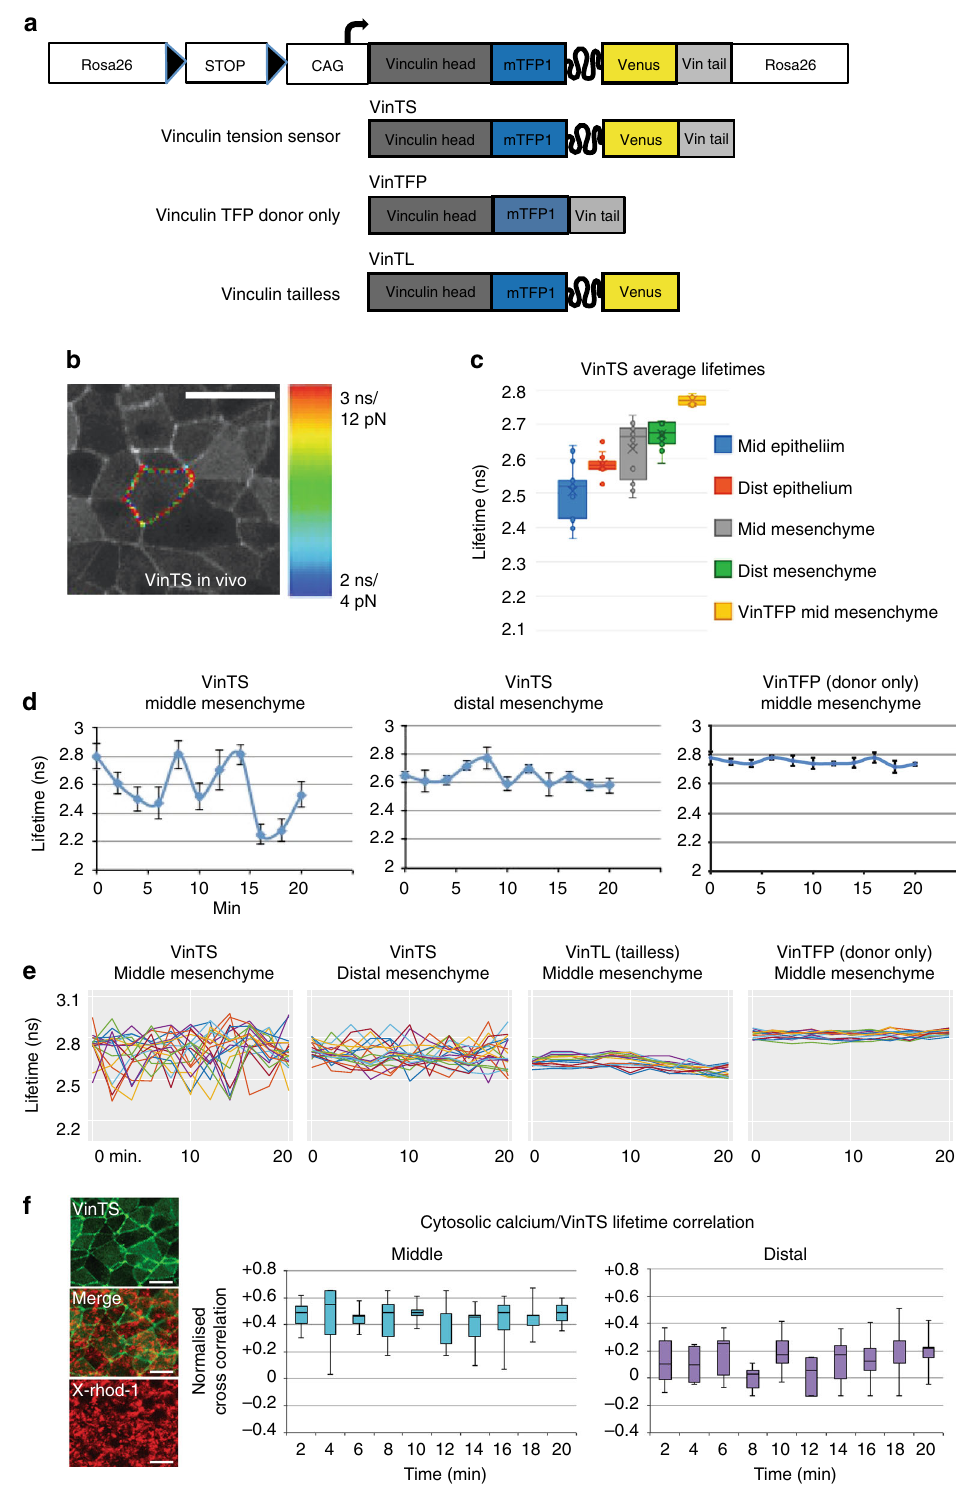
Fig. 6D, Supplementary Movie 27, 28) were diminished in the mutant middle arch. Together, these data imply that Wnt5a acts through the cell polarity and Ca 2 + pathways to promote and orient cell intercalations. The Wnt5a expression domain is biased distally and diminishes steeply within the middle region of the arch, but it